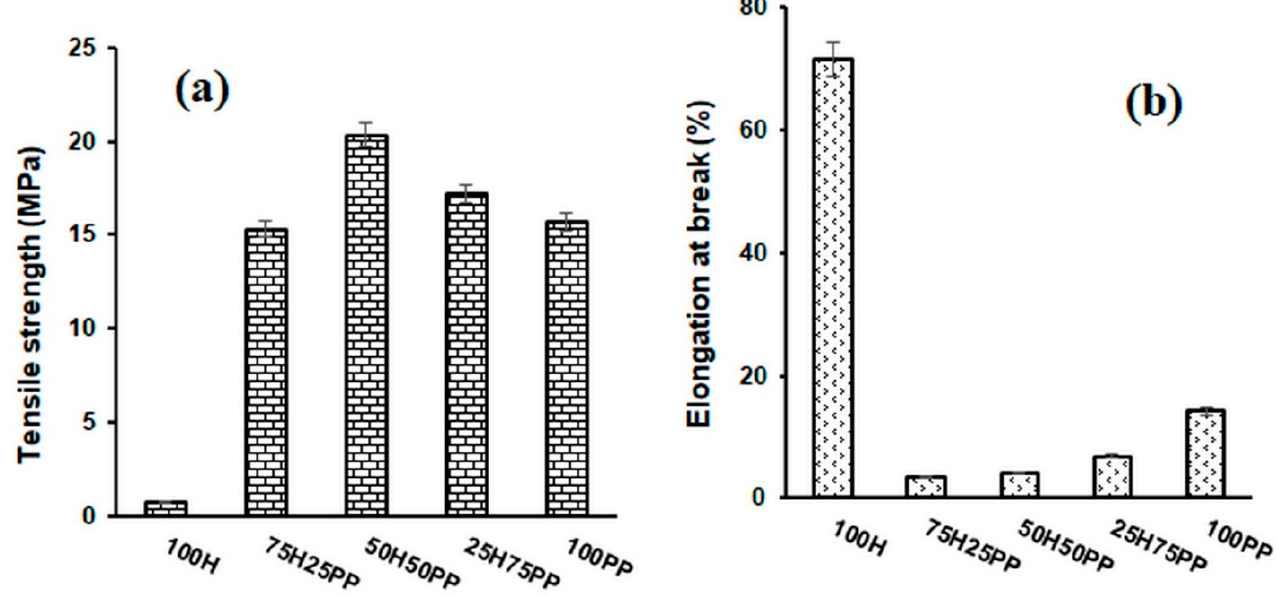
Figure 1. Variation in tensile strength ( a ) and elongation at break ( b ) for hemp and polypropylene– fibre composites.